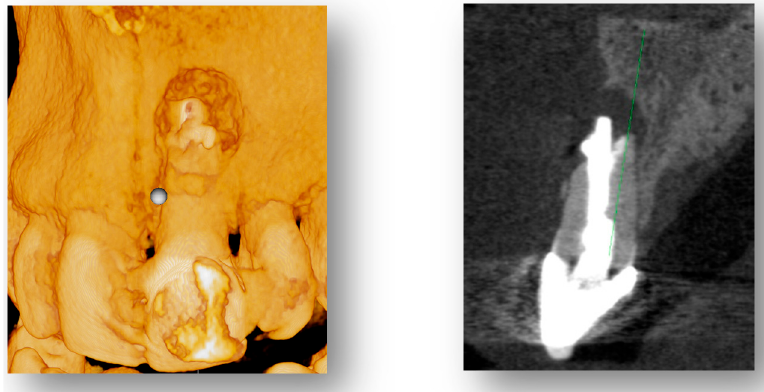
Figure 3. Three-dimensional (3D) rendering ( left image ) and CBCT cross-section ( right image ) a0 of periodontal defect with reduced scatter.